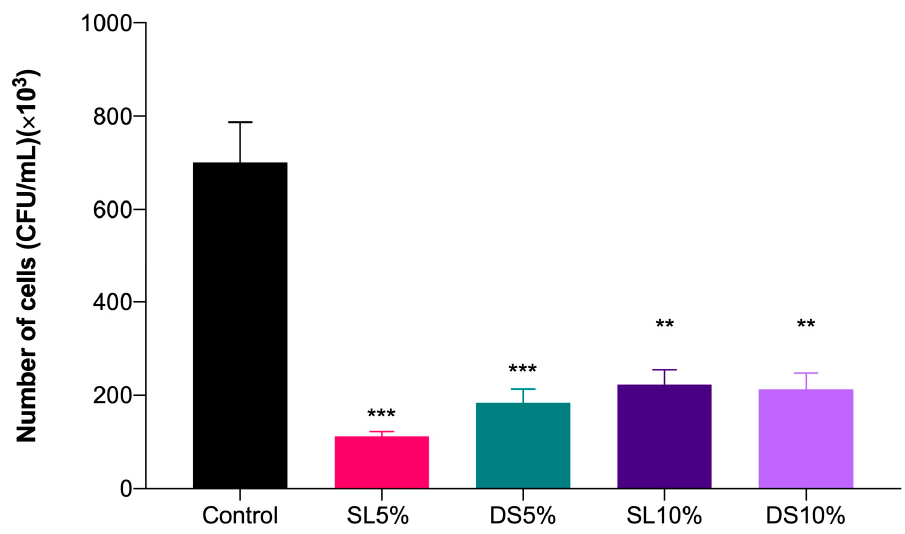
Figure 10. Bacterial count (CFU/mL) for the tested panels in an aquarium after 24 h of incubation. Data are presented as mean ± SEM ( n = 3). * * p < 0.01, *** p < 0.001 vs. Control.